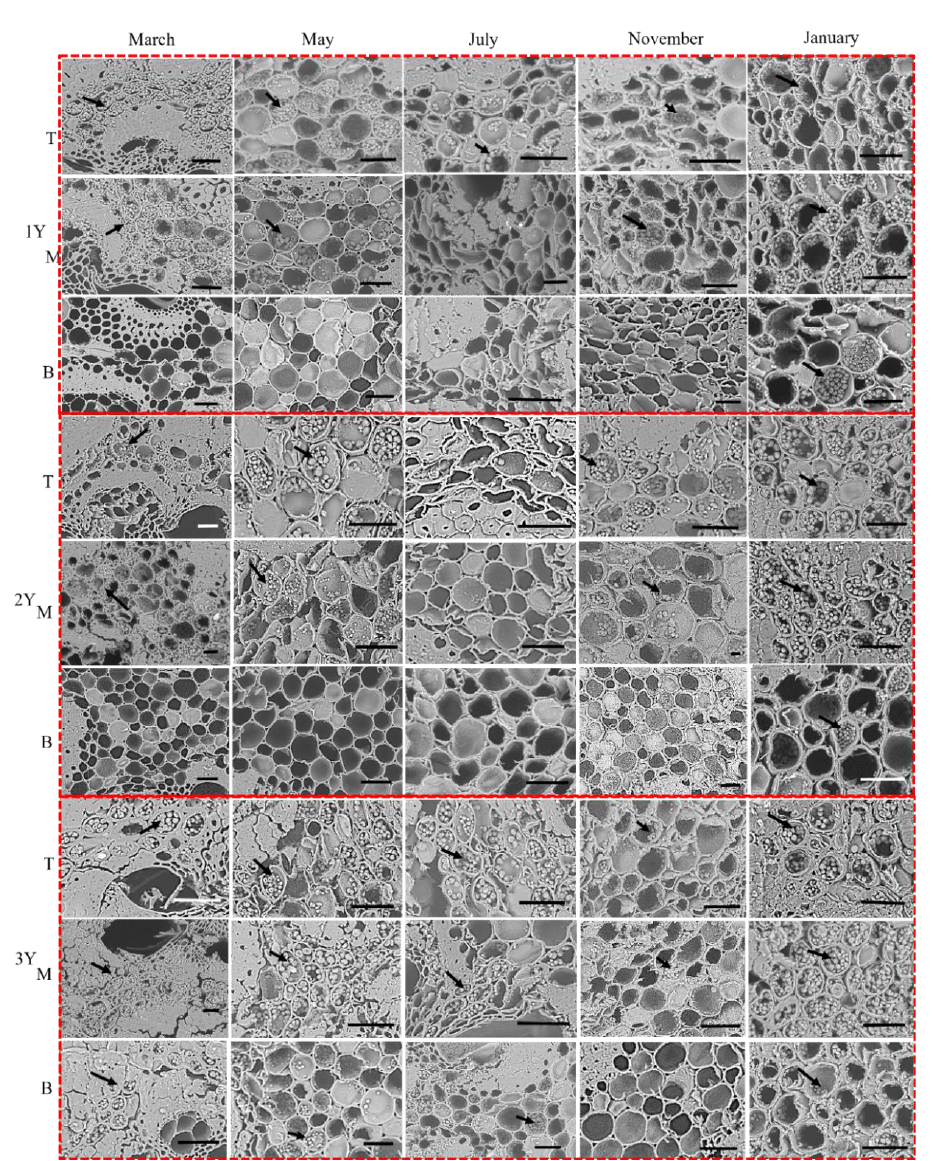
Figure 7. Starch granule distributions in Neosinocalamus affinis culms at different phenological stages.